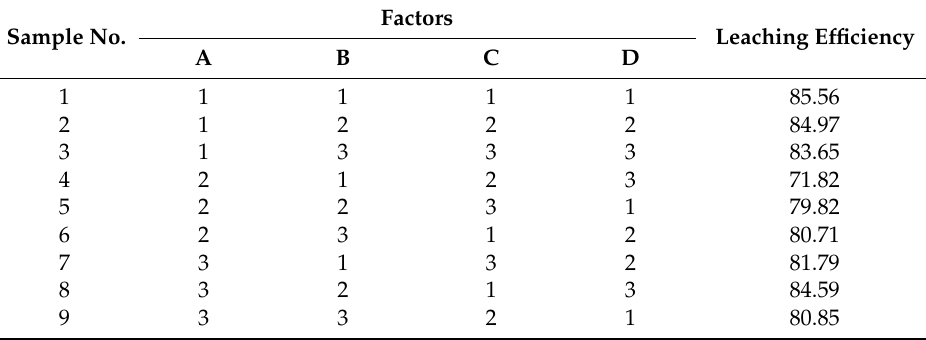
Table 4. L 9 (3 4 ) Orthogonal array design and acid leaching results of REE (%).